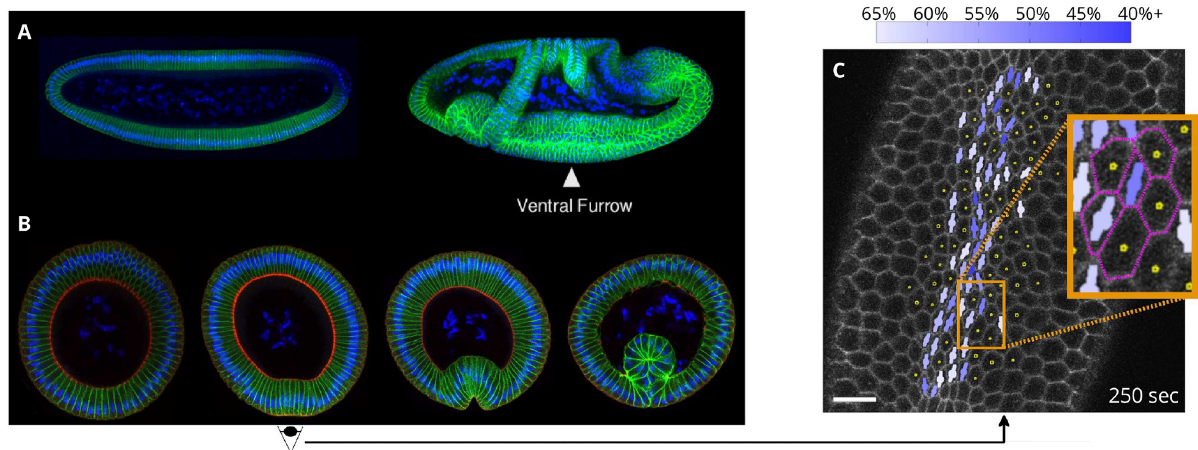
Fig 1. Ventral furrow formation in the Drosophila embryo. ( A ) The embryo before and after gastrulation; position of the ventral furrow is indicated. ( B ) Cross-sectional images of fixed embryos, showing the progression of VFF. The second image shows the stage imaged and analyzed. ( C ) Processed confocal microscopy image of a live Spider-GFP Drosophila embryo near the end of the initial slow apical constriction phase of VFF, showing apical cell constriction characteristics. Constricted cells are indicated by a bar with a circle (bar–circle), where the bar represents the direction and length of the major cell axis, and the size of the circle indicates the relative cell area. Color saturation specifies the degree of constriction, measured by the reduction of the cells minor axis length relative to the reference value (as defined in Eq 1 and indicated by the color bar). Tracked cells are indicated by dots. Scale bar: 10 μ m. Embryos (A,B) were stained with Hoeschst (blue) to visualize nuclei, antibodies to Neurotactin (green) to visualize cell membranes, and antibodies to Zipper (myosin heavy chain, red).